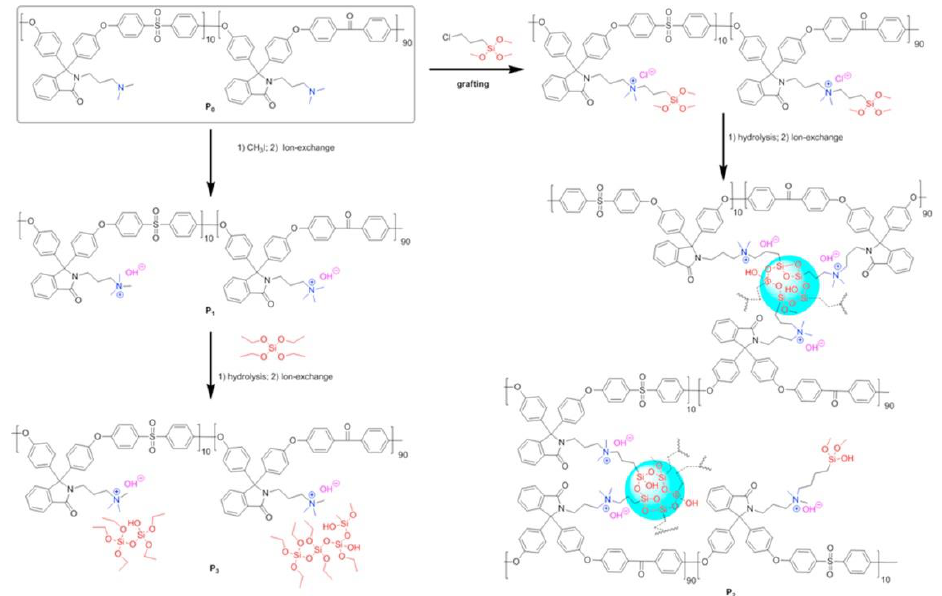
Figure 5. Synthesis routes for composite membrane ( left ) or linked silica network ( right ). Reprinted from Reference [80] with permission from Elsevier.